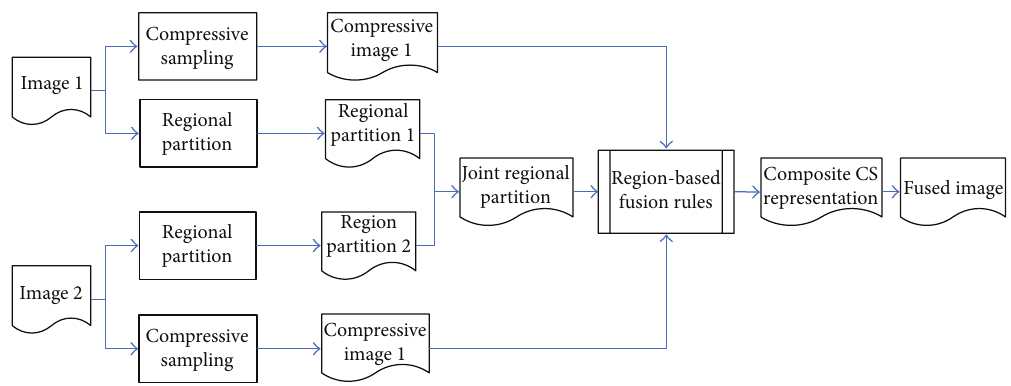
Figure 1: Region-based image-fusion framework for compressive